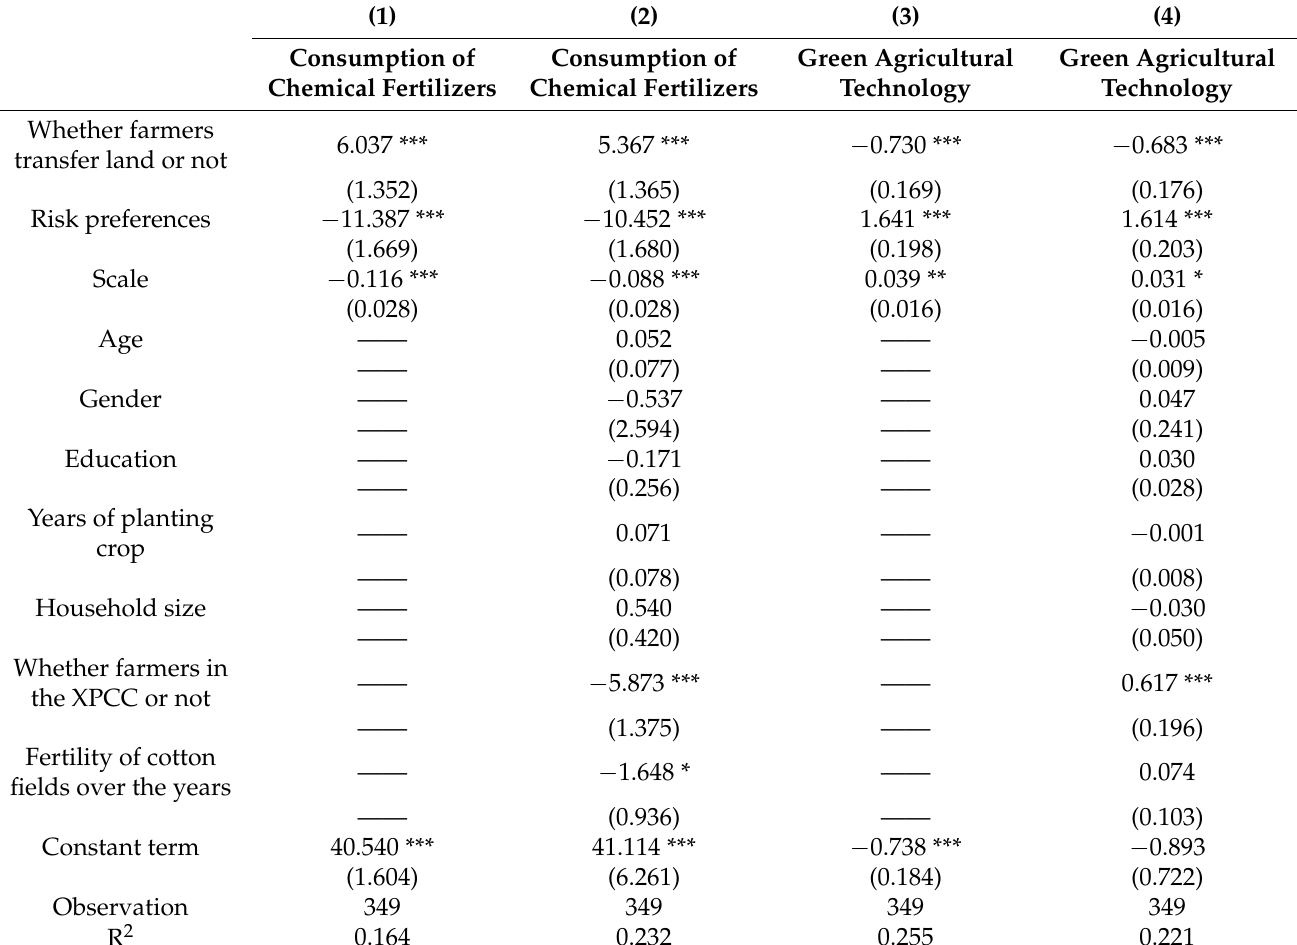
Table 2. Estimated results of land transfers and green production behavior of